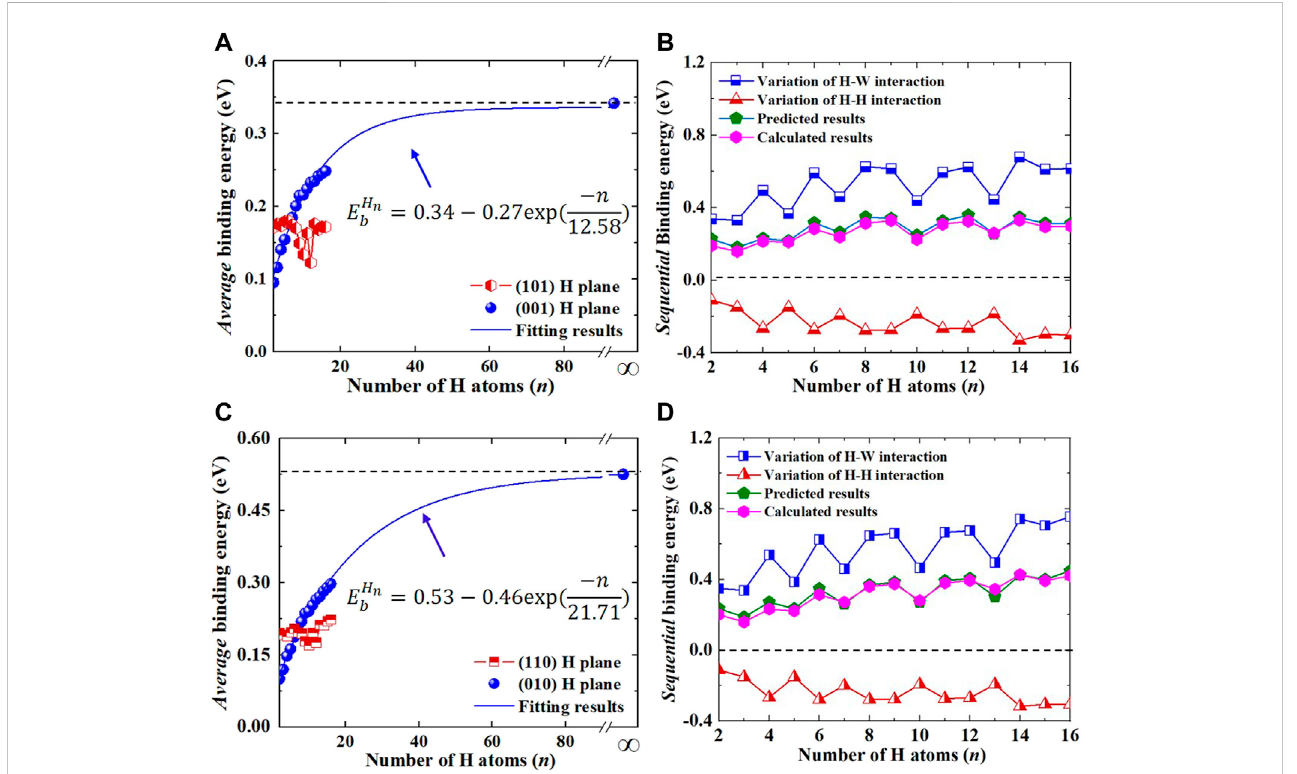
Figure 3C. Notably, in comparison with H platelets along (001) planes in strain-free W and under 1% tensile strain, the binding energy of H platelets under − 1% strain along (010) planes was much higher. For example, the largest sequential and average binding energies of H platelets reach up to 0.81 eV and 0.53 eV in compressive strained W, while in planar H clusters along (001) planes in strain-free/tensile strained W, they were only 0.61/0.74 and 0.29/0.34 eV,